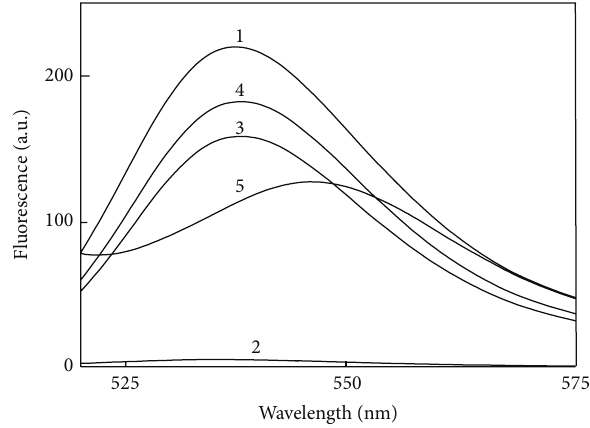
Figure 3: Fluorescence spectra of eosin Y ( 𝜆 aqueous solutions: (1) prior to sorption; after sorption on the CTS fiber, (2) polybasic and (3) polycationic forms; and on the CTS fiber, (4) polybasic and (5) polycationic